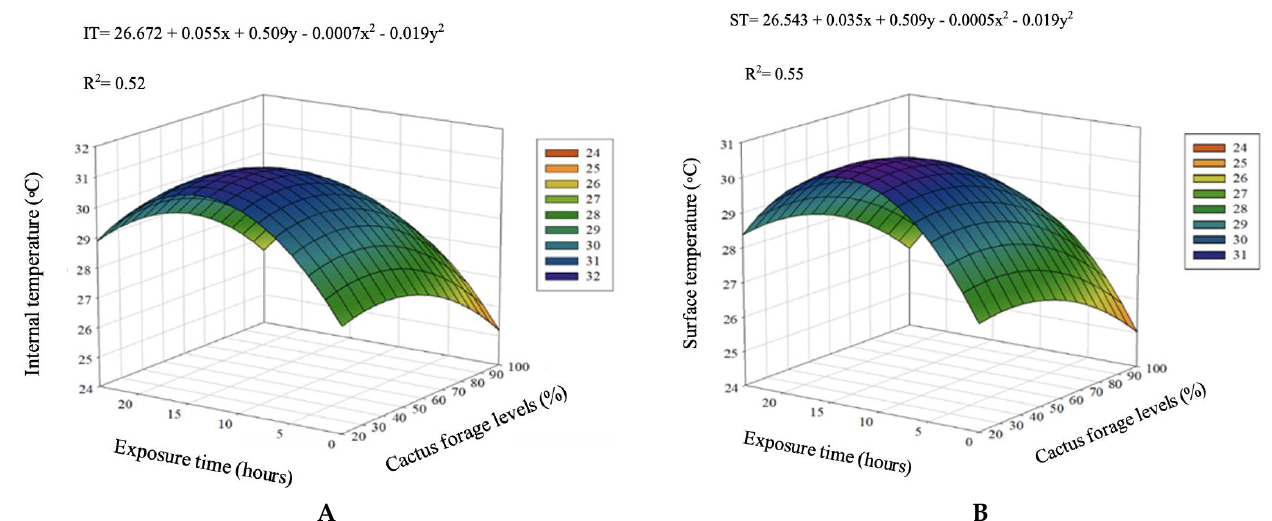
Figure 1. Internal temperature ( A ) and surface temperature ( B ) as a function of cactus forage levels and time of exposure to air.